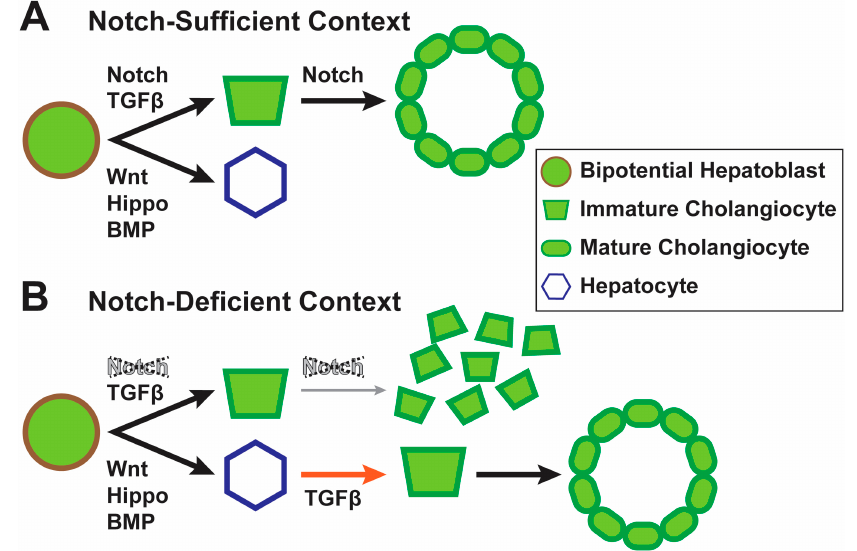
Figure 2. TGF β promotes hepatocyte to cholangiocyte transdifferentiation in livers with severe Notch deficiency. ( A ) In a Notch ‐ sufficient context, Notch and transforming growth factor beta (TGF β ) signaling help in specifying cholangiocytes and promoting the development of mature biliary structures. Wingless ‐ type MMTV integration site (WNT), Hippo and bone morphogenetic protein (BMP) signaling promote hepatocyte fate. ( B ) In a severe Notch ‐ deficient context, biliary morphogenesis is impaired and TGF β signaling promotes transdifferentiation of hepatocytes to cholangiocytes (the orange arrow) to form patent biliary structures [35].